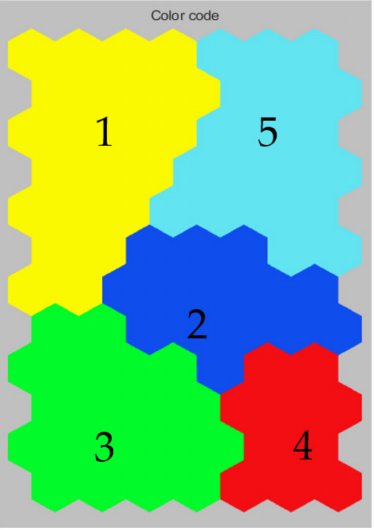
Figure 11. SOM clusters: the data clusters are based on each sample’s characteristics, comparing each with all other samples and seeking relationships between them.